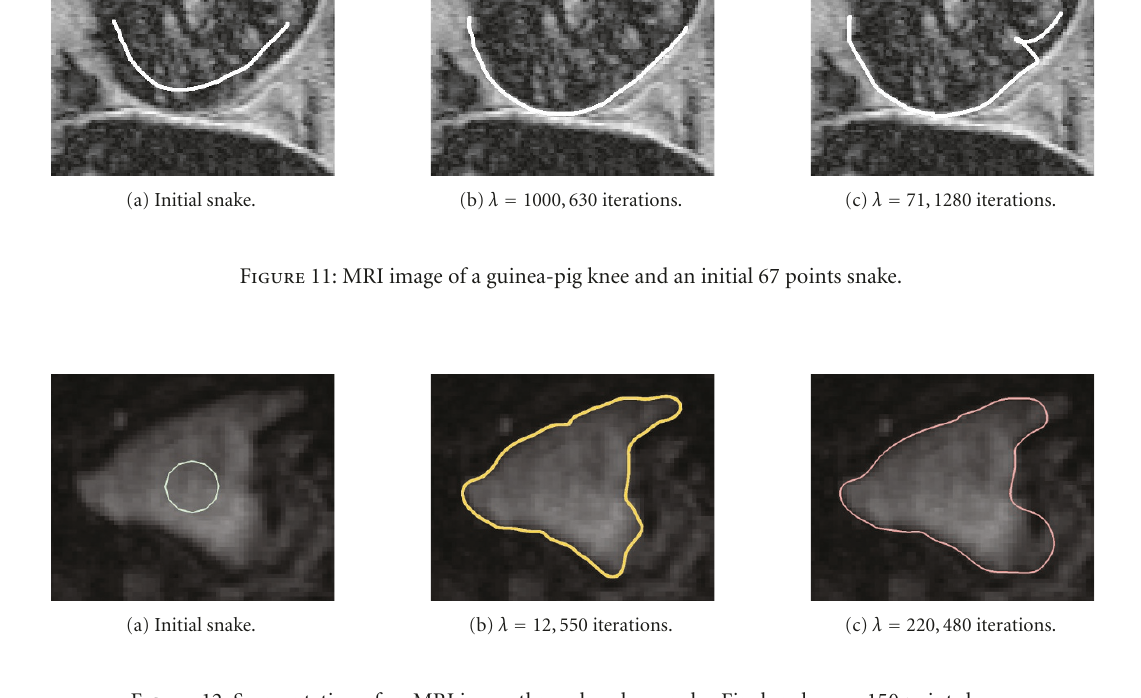
Figure 12: Segmentation of an MRI image through a close snake. Final snakes are 150 points